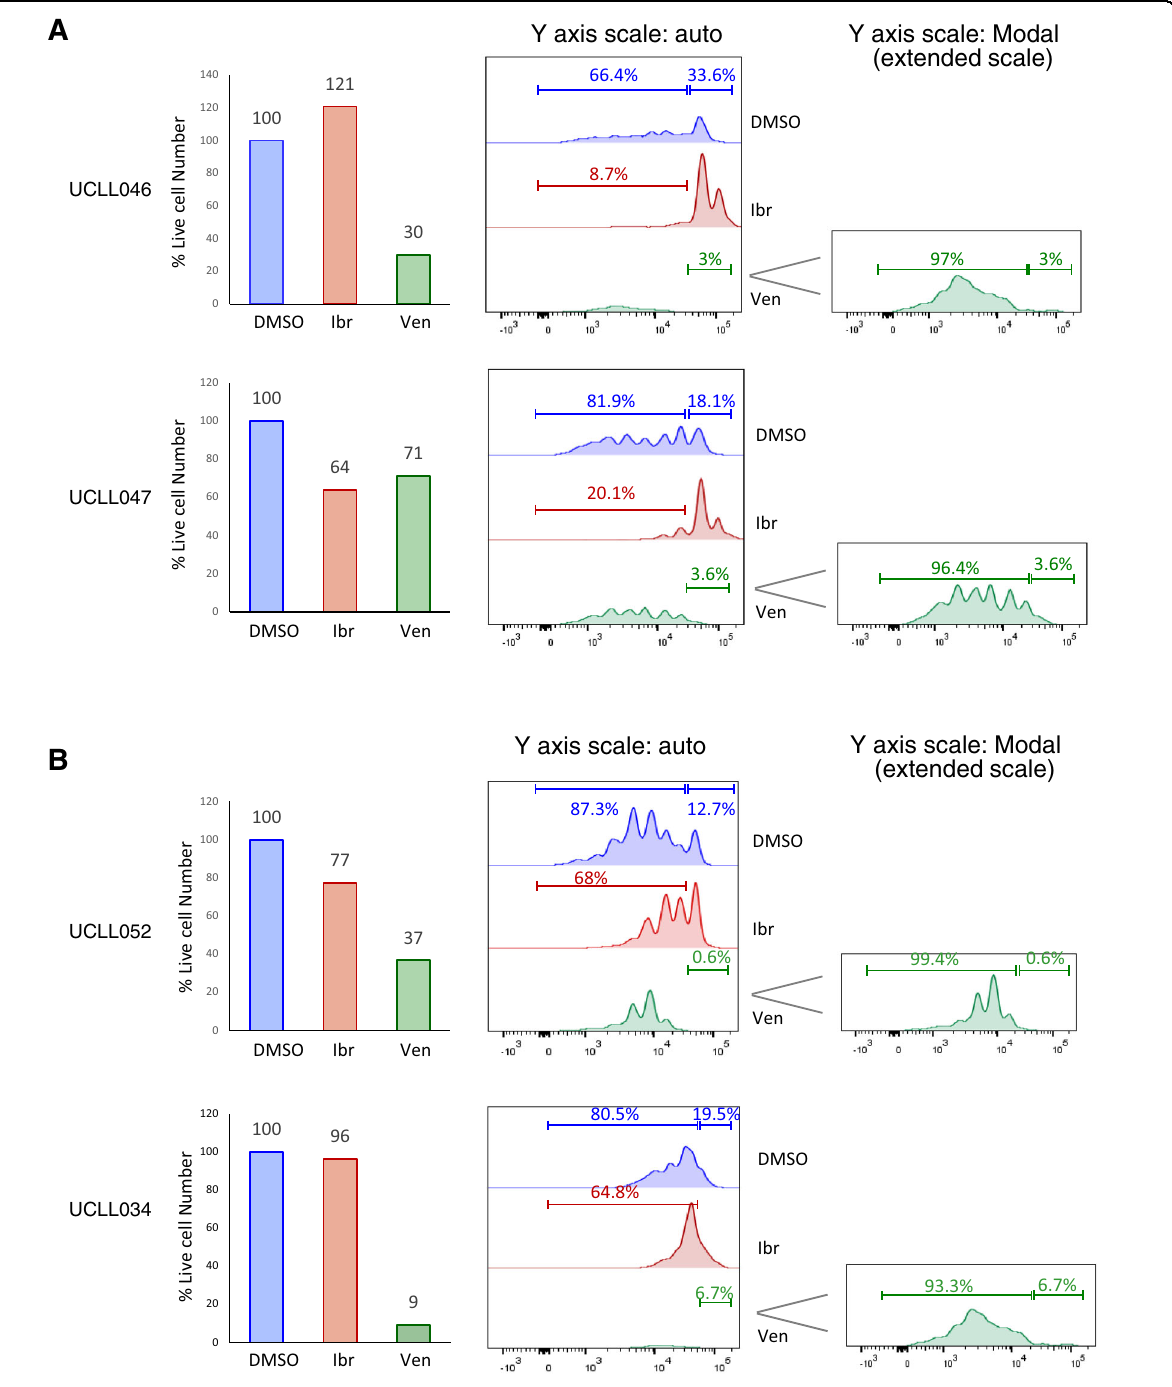
Fig. 3 The resting subpopulation of CLL, as opposed to the dividing one, preferentially responds to venetoclax. CFSE-labeled CLL cells were cultured with BMF + CpG/IL-15 in the presence of DMSO, 400 nM of ibr or 200 nM of venetoclax (ven). All analyses shown were conducted at day 7 of the co-culture by fl ow cytometry. A Live cell numbers (bar graphs) and CFSE pro fi les of two ibrutinib naïve/sensitive cases. Live cell numbers were normalize to the DMSO control (100%). Percentage of cells distributed in the dividing phases of the CFSE pro fi les is automatically calculated by the FlowJo software. Y axis scale-auto displays events on the same scale for all treatment conditions, and Y axis scale-Modal displays events on an extended scale to show low peaks under the condition of ventoclax treatment. B Live cell numbers and CFSE pro fi les of two ibrutinib resistant